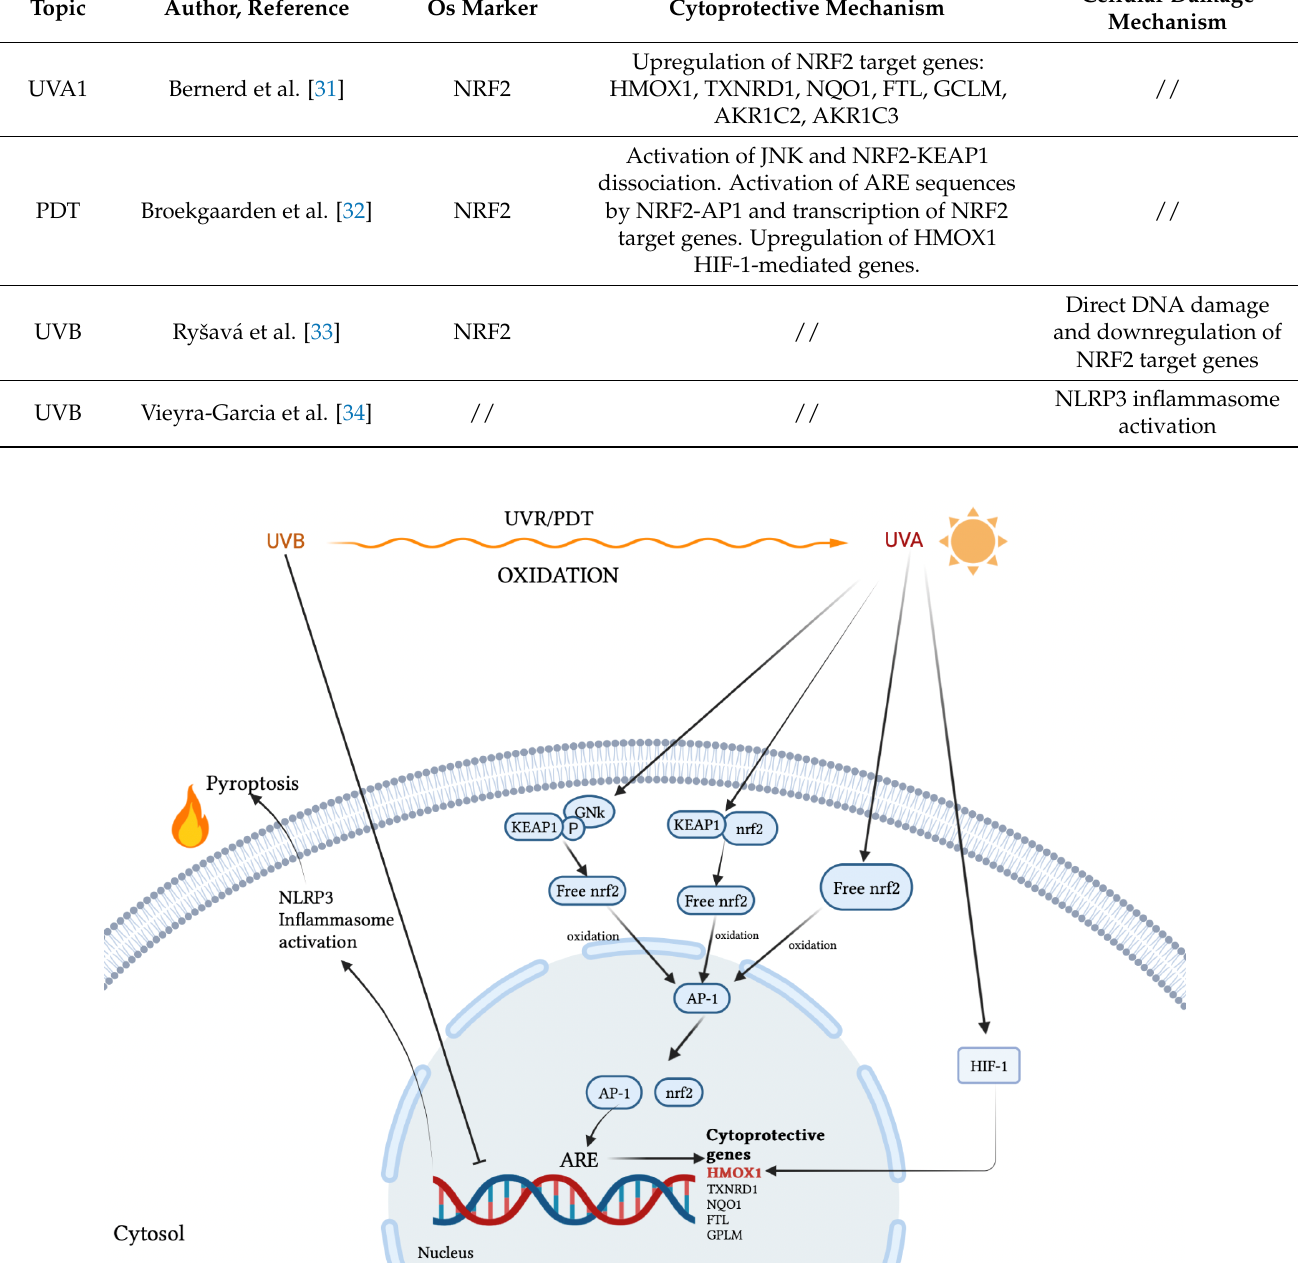
Figure 3. Overall proportion of serious (Panel A) and non-serious AEs (Panel B) for bevacizumab and lenvatinib plus chemotherapy (no strata by chemotherapy combinations).